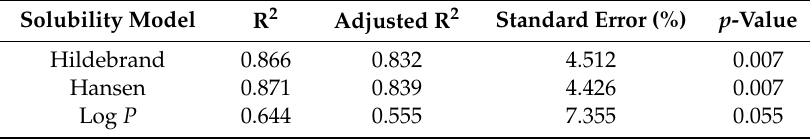
Table 6. The results of multiple linear regression for solubility